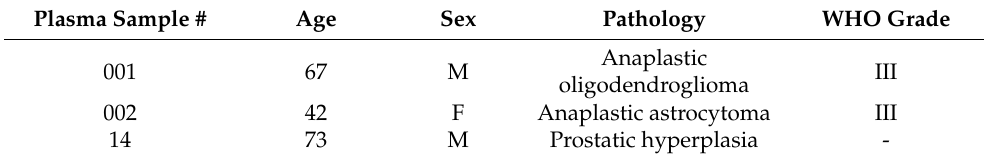
Table 1. Clinical and morphological characteristics of glioma patients and healthy volunteer. Plasma Sample # Age Sex Pathology WHO Grade